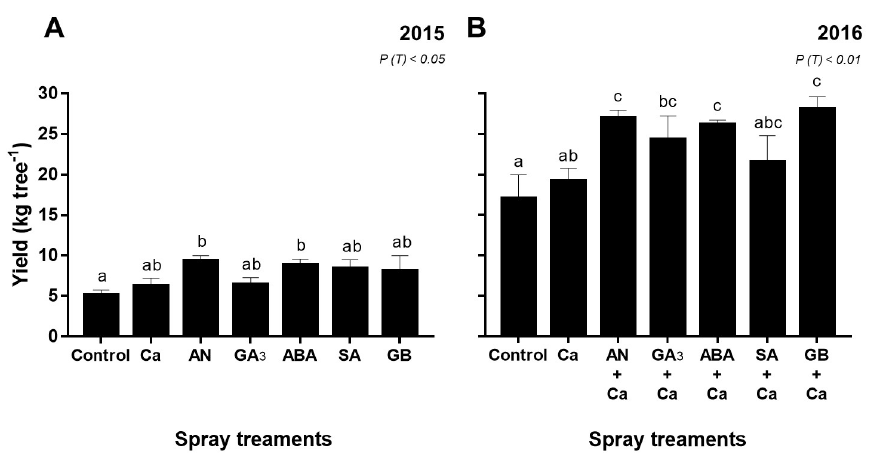
Figure 4. Yield (kg tree − 1 ) of ‘Skeena’ cherry trees after spray treatments application in 2015 ( A ) and 2016 ( B ). Each column is expressed as mean ± SE (n = 6). Different letters indicate significant differences ( P < 0.05 ) among treatments by Duncan’s test.